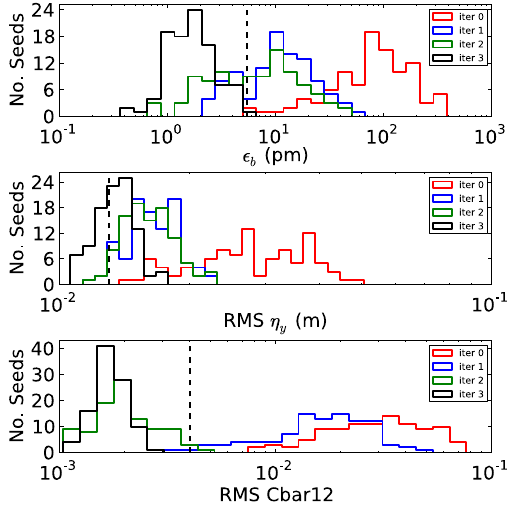
FIG. 4. Results from RING _ MA 2, using misalignments, BPM measurement errors, and multipoles stated in Tables VII, VIII, and IX, plotted before correction (red line), and after first, second, and third stage of emittance correction (blue, green, and black lines, respectively). The dashed black line indicates typical measured values in CESR after low-emittance